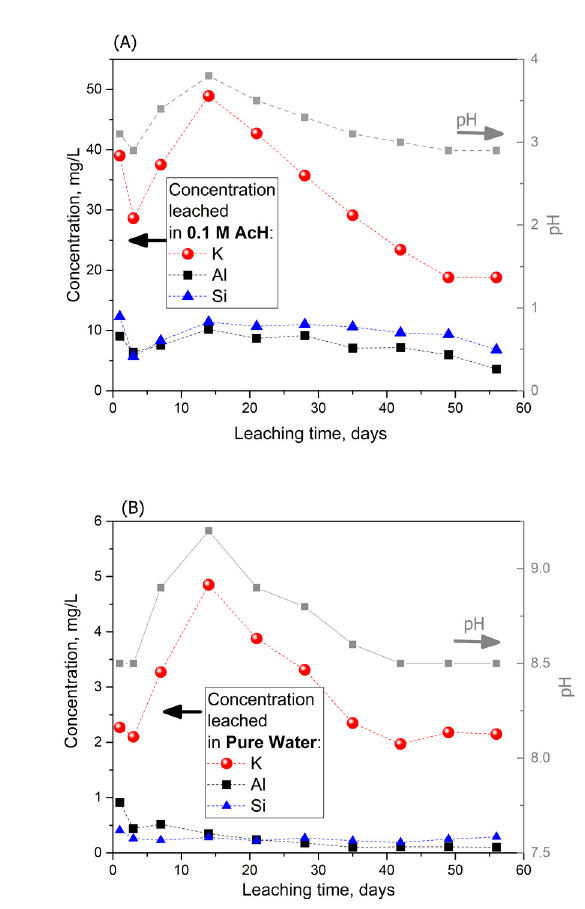
Figure 3. Concentration of eluted elements and the pH of the replenishing solutions over time. A) Leaching in acetic acid (AcH) and B) in pure water.